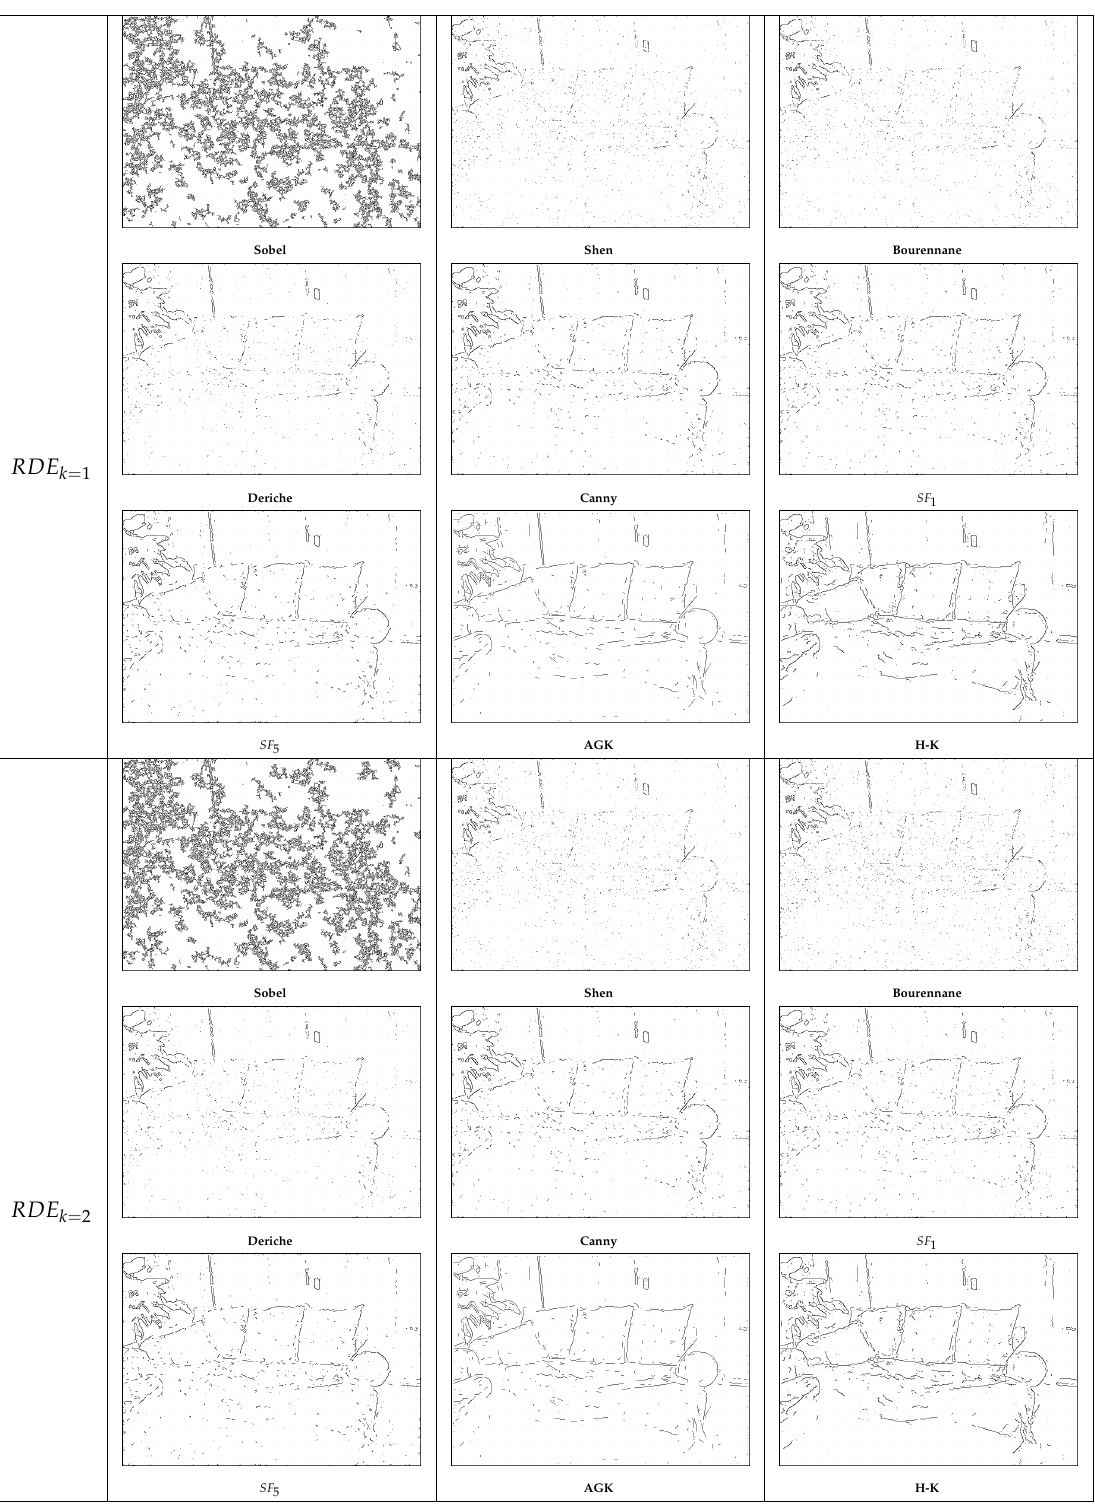
Figure 27. Ideal segmentations for several edge detectors on image 109, PSNR = 14